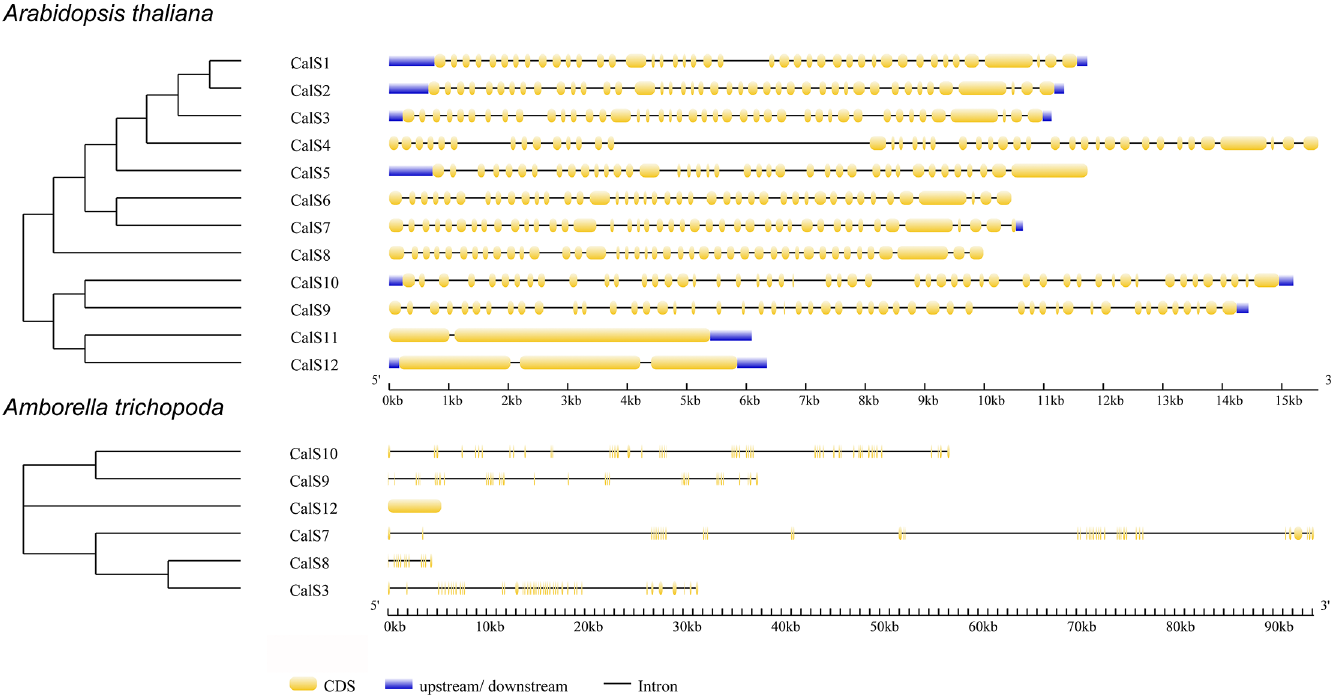
Fig 8. Comparison of the number and arrangement of introns and exons for representative species from a derived angiosperm ( Arabidopsis thaliana ) and a basal angiosperm ( Amborella trichopoda ).